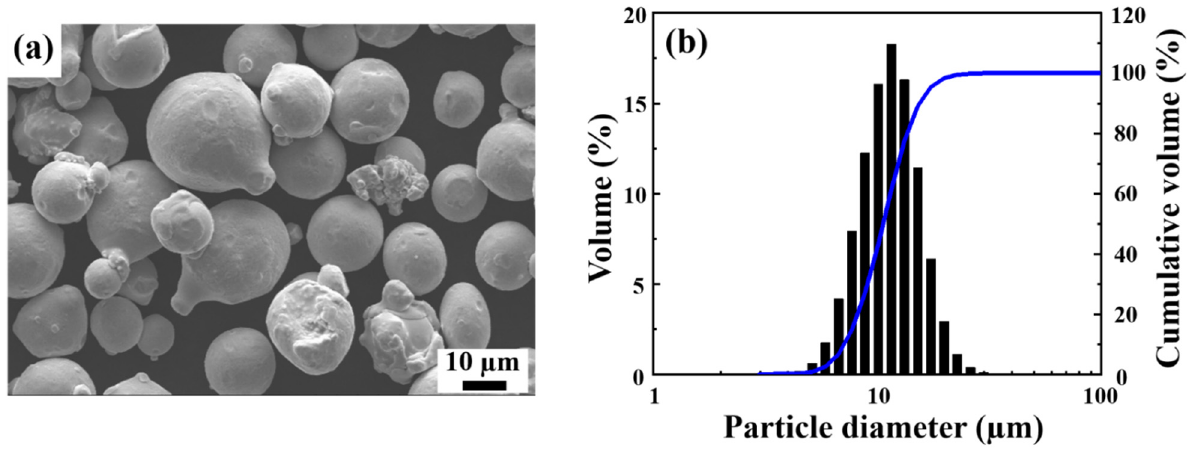
Figure 2. ( a ) SEM image and ( b ) particle size distribution of 17-4 PH stainless steel powder. Table 1. Chemical compositions (wt.%) of 17-4 PH stainless steel powder.